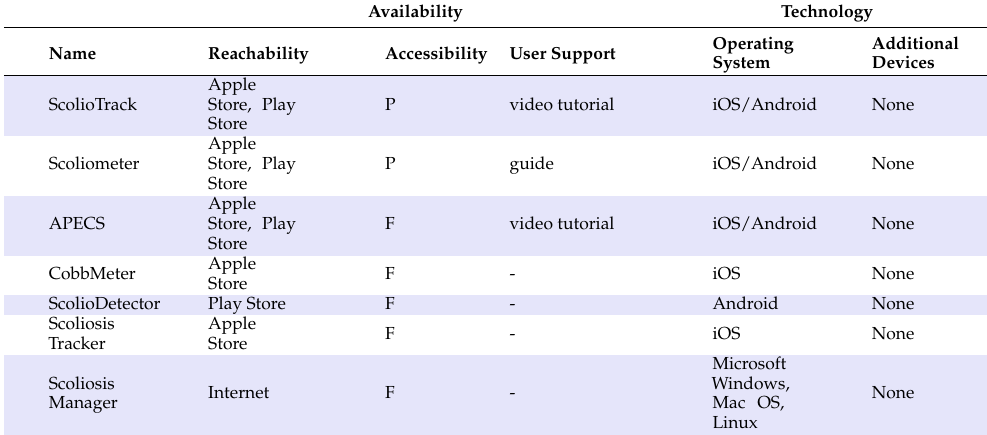
Table 1. Comparison of the tools with respect to availability and technology macro-categories. P means pay, F means free, and “-” means not